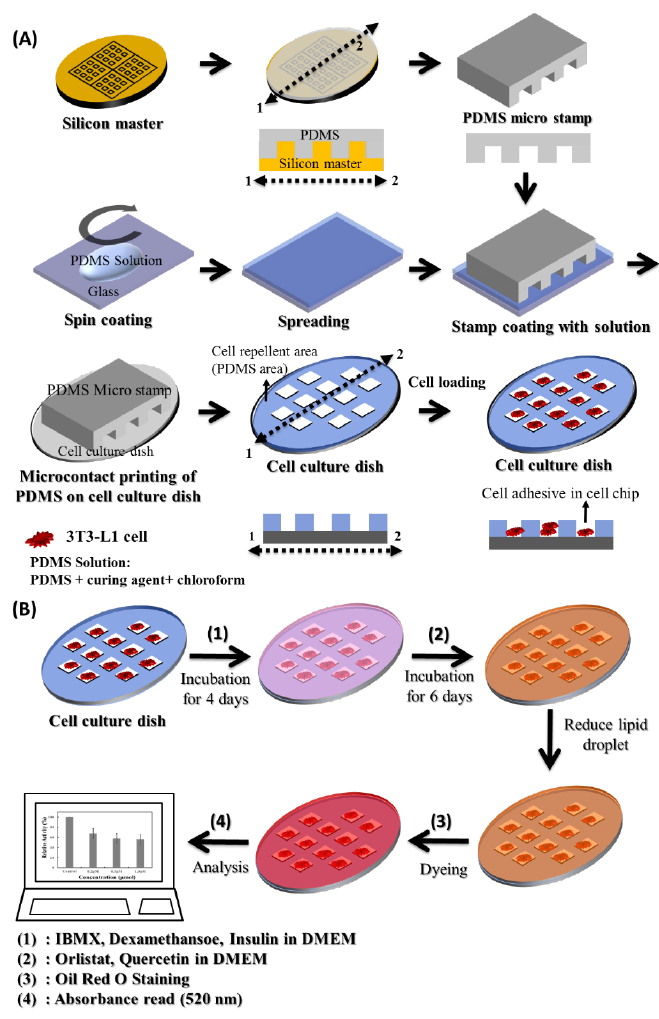
Figure 1. Schematic diagram showing an adipocyte micro-cell pattern chip. ( A ) Fabrication of the micro-cell pattern chip. PDMS: polydimethyl-siloxane. ( B ) Schematic of mouse embryo fibroblast cell (3T3-L1) differentiation by anti-obesity agents and 3T3-L1 cell differentiation analyzed by Oil Red O staining. IBMX: 3-isobutyl-1-methylxanthine; DMEM: Dulbecco ’s modified Eagle’s medium .